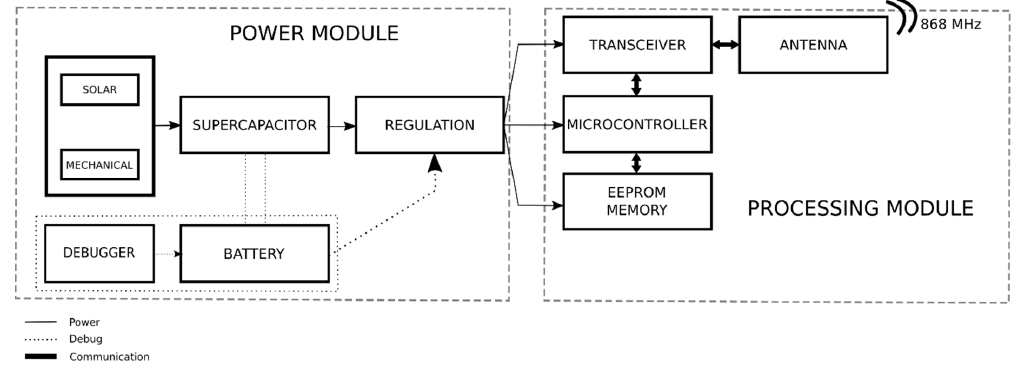
Figure 1. Autonomous active tag architecture. Normal operation: energy is obtained from solar and mechanical harvest submodules, which is stored in a supercapacitor and regulated to feed the diverse elements of the processing module. This is indicated by simple arrows. Bold lines reflect the communication of data between submodules. Dotted lines show the elements oriented to debugging the device. The double dotted line between storage and battery means that the battery is connected to the storage submodule.